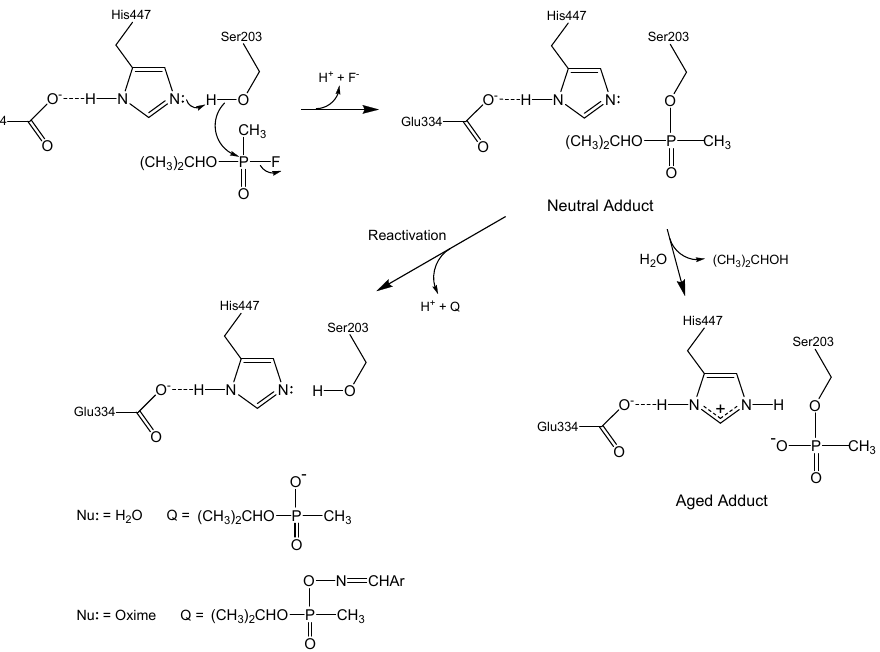
Figure 1. Inhibition of AChE by the organophosphorus nerve agent sarin.